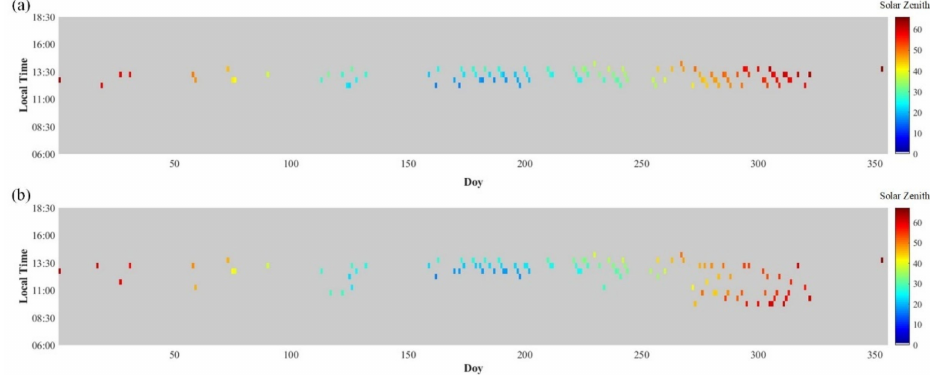
Figure 4. The time, date and solar zenith angle of the quality-controlled matchups between FY-3D MERSI-II observations and in-situ measurements at Railroad Valley Playa site involved in calibration procedure in this study: ( a ) FY-3D MERSI-II observations; ( b ) in-situ